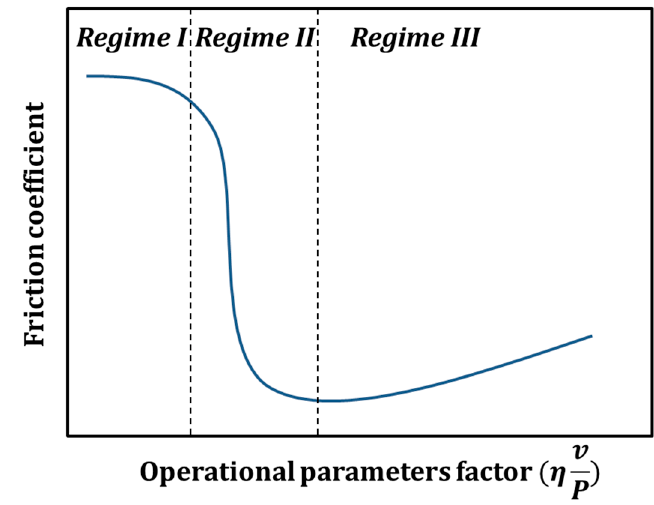
Figure 2. Typical Stribeck curve for liquid lubrication and associated regimes.